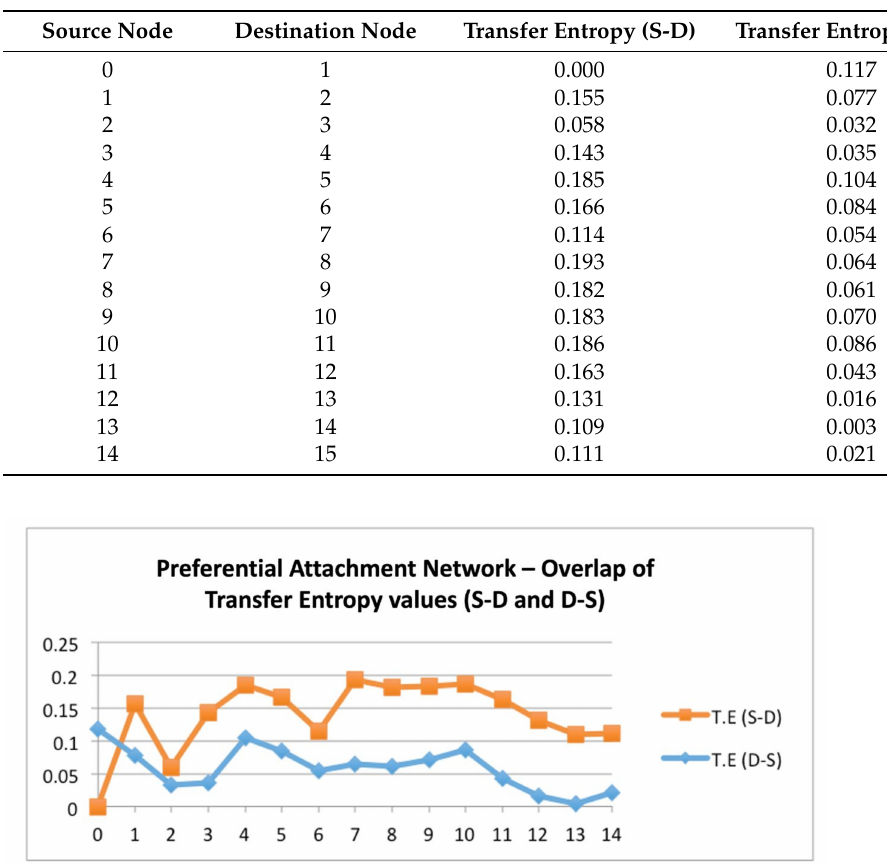
Table 3. TE values calculated based on node degrees from Table 2.